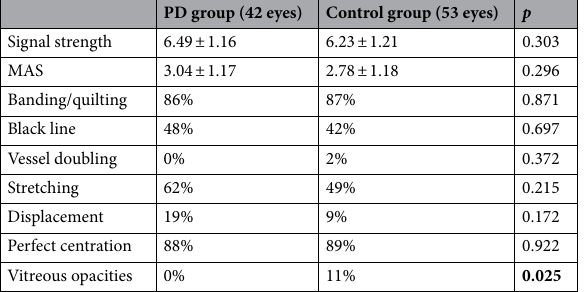
Table 4. Image quality assessment of the selected subgroup. MAS motion artifact score; Results are reported as mean ± standard deviation (range) or as percentage of affected images. p < 0.05 was considered statistically significant and bold font indicates statistical